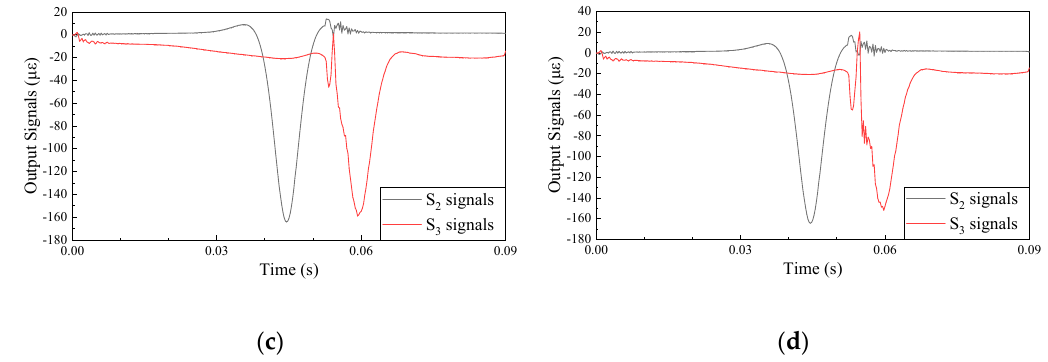
Figure 14. Output signals of Plan III under its most unfavorable condition: ( a ) Without wheel flat; ( b ) wheel flat depth of 0.1 mm; ( c ) wheel flat depth of 0.3 mm; and ( d ) wheel flat depth of 0.5 mm.